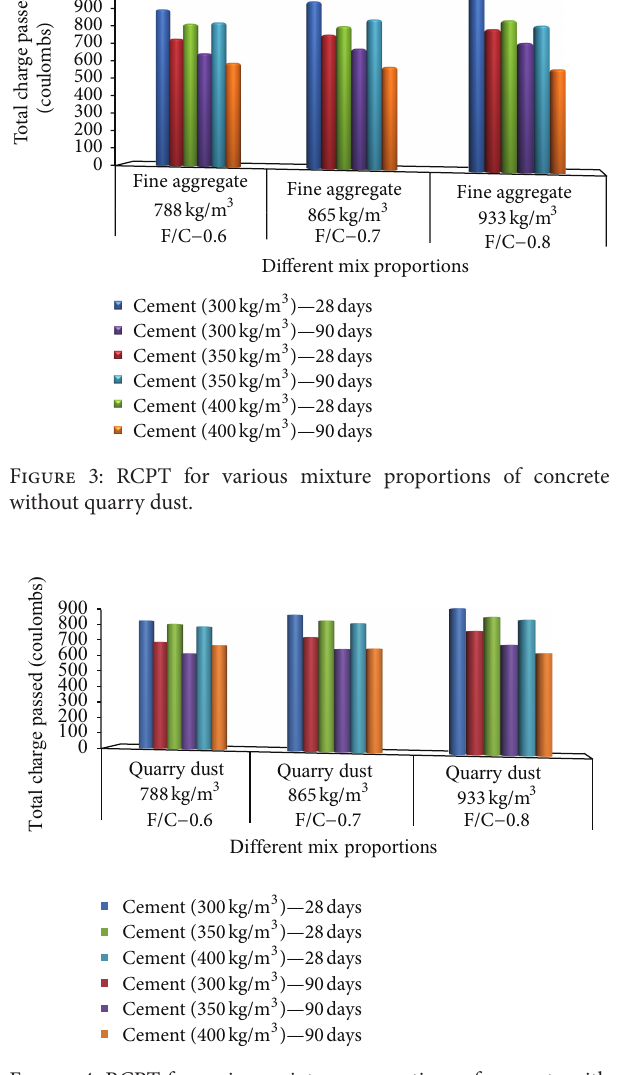
Figure 4: RCPT for various mixture proportions of concrete with quarry dust.